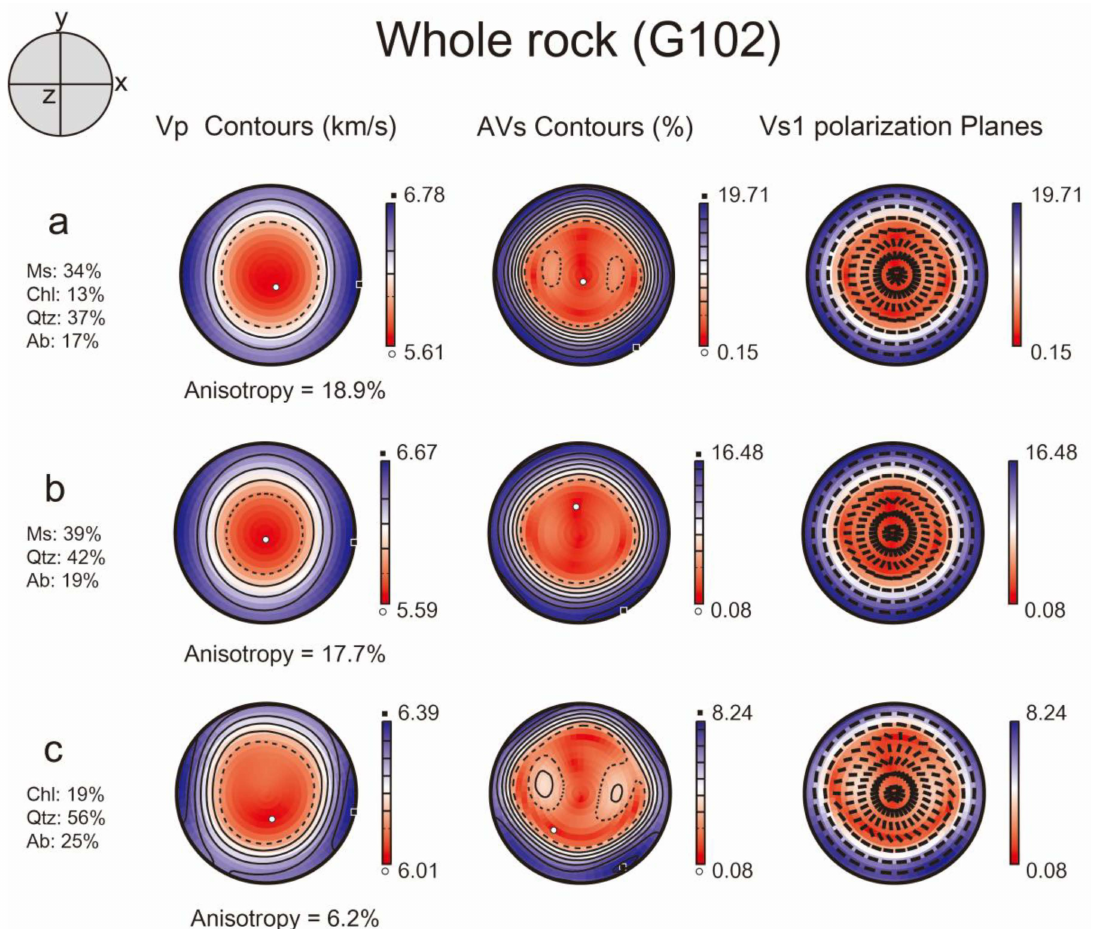
Figure 11. Whole rock seismic property of sample G102 calculated from LPOs, volume proportions and elastic con- stant of each mineral. ( a ) Seismic anisotropy of muscovite + chlorite + quartz + albite. ( b ) Seismic anisotropy of mus- covite + quartz + albite. ( c ) Seismic anisotropy of chlorite + quartz + albite. The P-wave velocity (Vp), amplitude of the shear-wave anisotropy (AVs), and polarization direction of the faster shear wave (Vs1) are plotted in the lower hemisphere using an equal-area projection. E–W direction of each figure corresponds to stretching lineation (X), and Z is normal to the